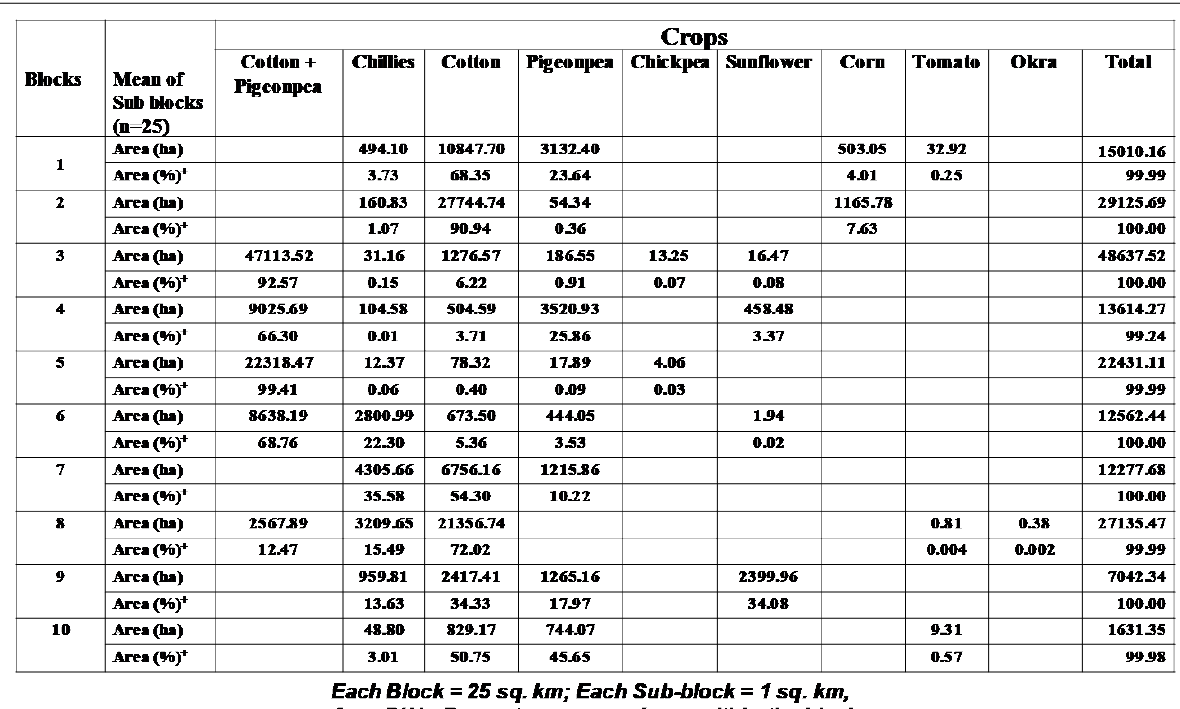
Table-1. Mean and percentages of crop acreages of various crops of